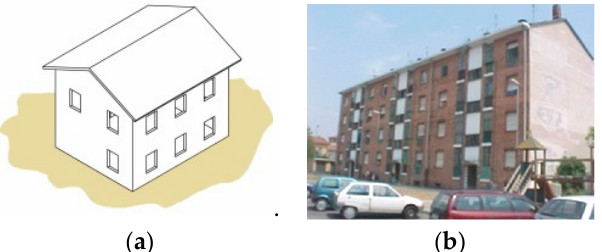
Figure 1. Italian residential building-types of the construction period 1946–1960, according to the IEE-TABULA project: single-family house ( a ) and apartment block ( b ).